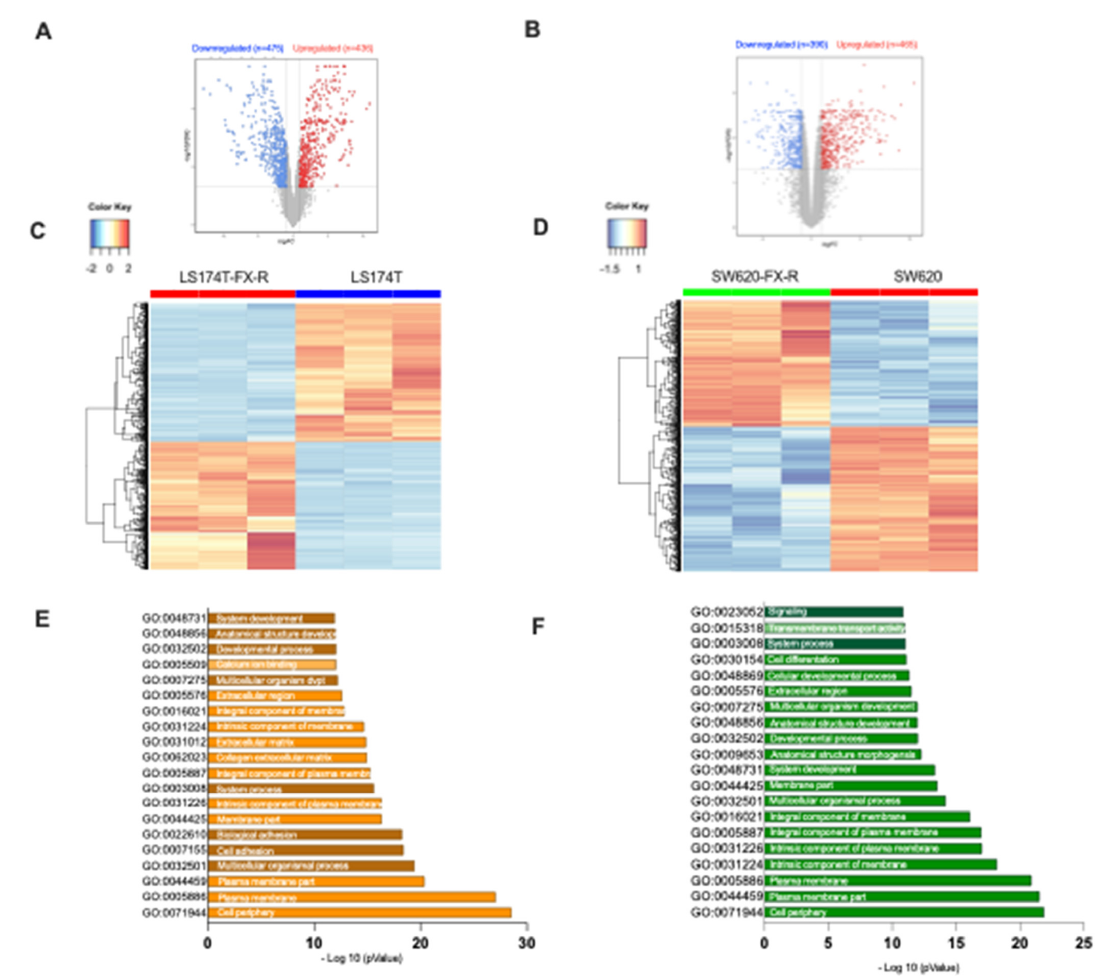
Figure 4. RNA-sequencing data for LS174T and SW620 cells and their FX-R clones. RNA-sequencing (RNA-seq) was performed to study the differential gene expression based on analysis of CRC FX- treated and FX-naïve cells. Volcano plots of significant genes ( p -value with FDR < 0.05) and a fold change > 2 (logFC) in ( A ). LS174T-FX-R vs. LS174T and ( B ). SW620-FX-R vs. SW620 cells. Each dot is a gene with the most upregulated genes are towards the right, the most downregulated genes are towards the left, and the most statistically significant genes are towards the top. Here, the blue dots represent the downregulated genes and the red ones represent the upregulated genes. Vertical lines highlight log2 fold changes of − 1 and +1 (FC = 2 <=> log(FC) = 1), while a horizontal line represents a corrected p -value of 0.05. For LS174T cells, panel A = 911 genes–downregulated (n = 475) and upregulated (n = 436); for SW620, panel B= 855- downregulated (n = 390) and upregulated (n = 465). Heatmap of genes in ( C ). LS174T-FX-R vs. LS174T and ( D ). SW620-FX-R vs. SW620 describe cells differentially up- and downregulated. The color and intensity of the boxes are used to represent expression values: blue for a gene with a small expression value and red with a high value (according to the color key) ( E , F ). Enrichment analysis of both up and downregulated genes in LS174T (N = 3, n = 3) and SW620 (N = 3, n = 3) for Gene Ontology. The top 20 functional clusters are sorted according to p -value and color coding corresponds to cellular components, biological processes, and molecular